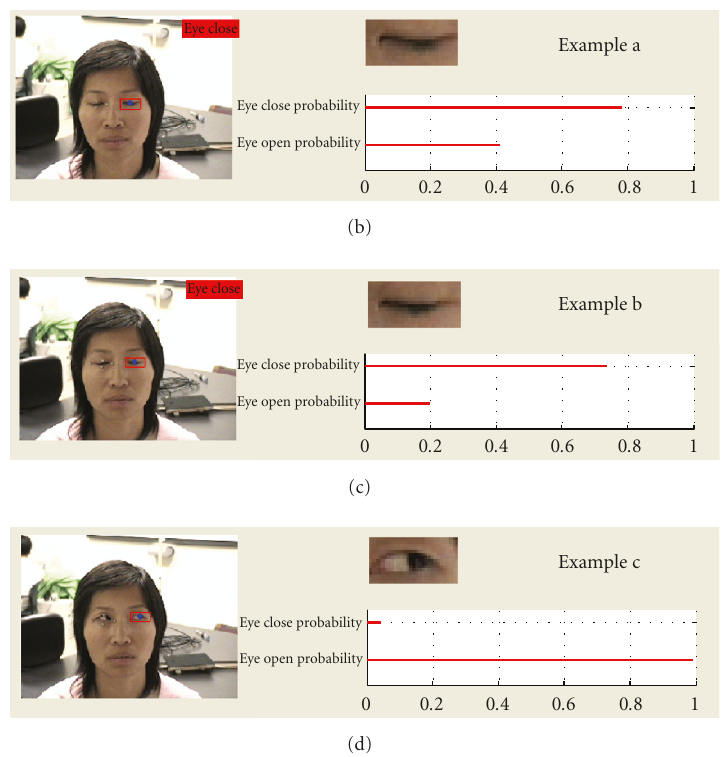
Figure 10: (a) The log ratio of posteriors log( p o /p c ) for each frame in Seq. 5. (b)–(d) The frames corresponding to examples a, b, and c in Figure 10(a). The tracked eyes and the posteriors p c and p o are also shown. In each figure, the top red line shows the posterior of being closed eye, and the bottom red line shows the posterior of being open